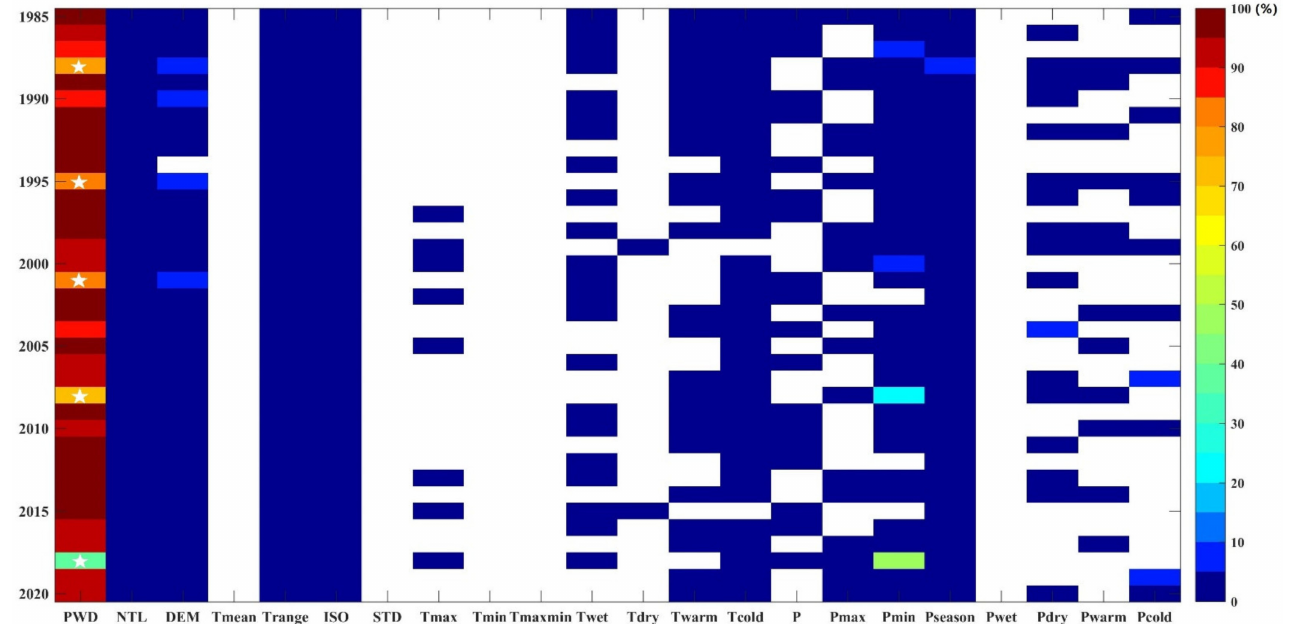
Figure 4. Permutation importance values of annual environmental factors in the MaxEnt models between 1985 and 2020 (white stars denote the years with significant changes in the PWD distribution). Null values (white spaces in the figure) indicate that the environmental variables were not selected using the Pearson’s correlation coefficients test for that